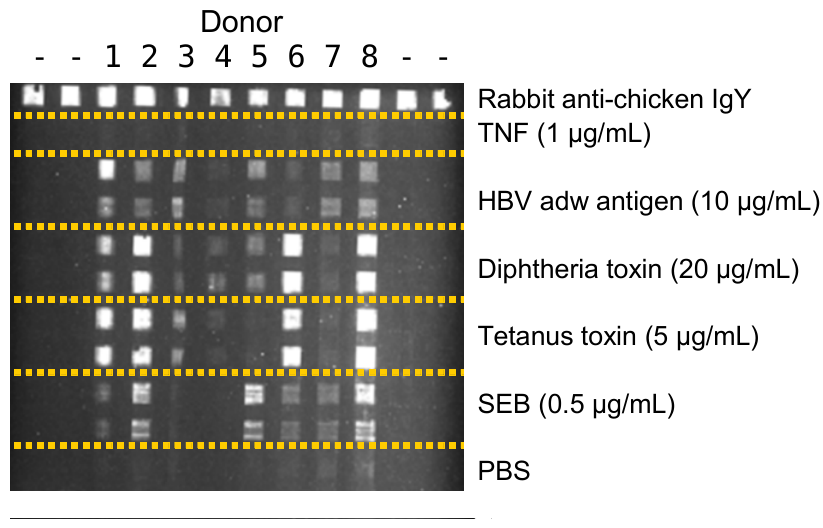
Figure 4 . Pattern of binding by sera from 8 donors with varied immunologic histories. Arrays of immobilized toxins or antigens (shown to the right of image) were used to test sera of 8 donors (indicated above image) with varied histories of vaccination and exposure to antigens. After sera were incubated with the arrays, Cy5-labeled anti-human IgG was used as a tracer. TNF = human tumor necrosis factor [control], HBV adw = hepatitis B virus adw antigen [vaccine component], PBS = phosphate-buffered